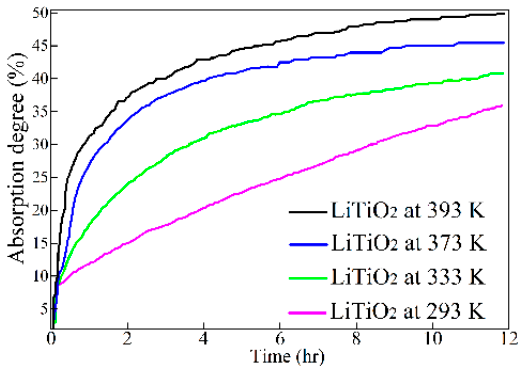
Figure 4. Comparison absorption degree of CO 2 between LiTiO 2 . Table 3. Absorption degree of LiTiO 2 at 293K–393 K for the absorption time of 2–11.75 h. Temperature (K)